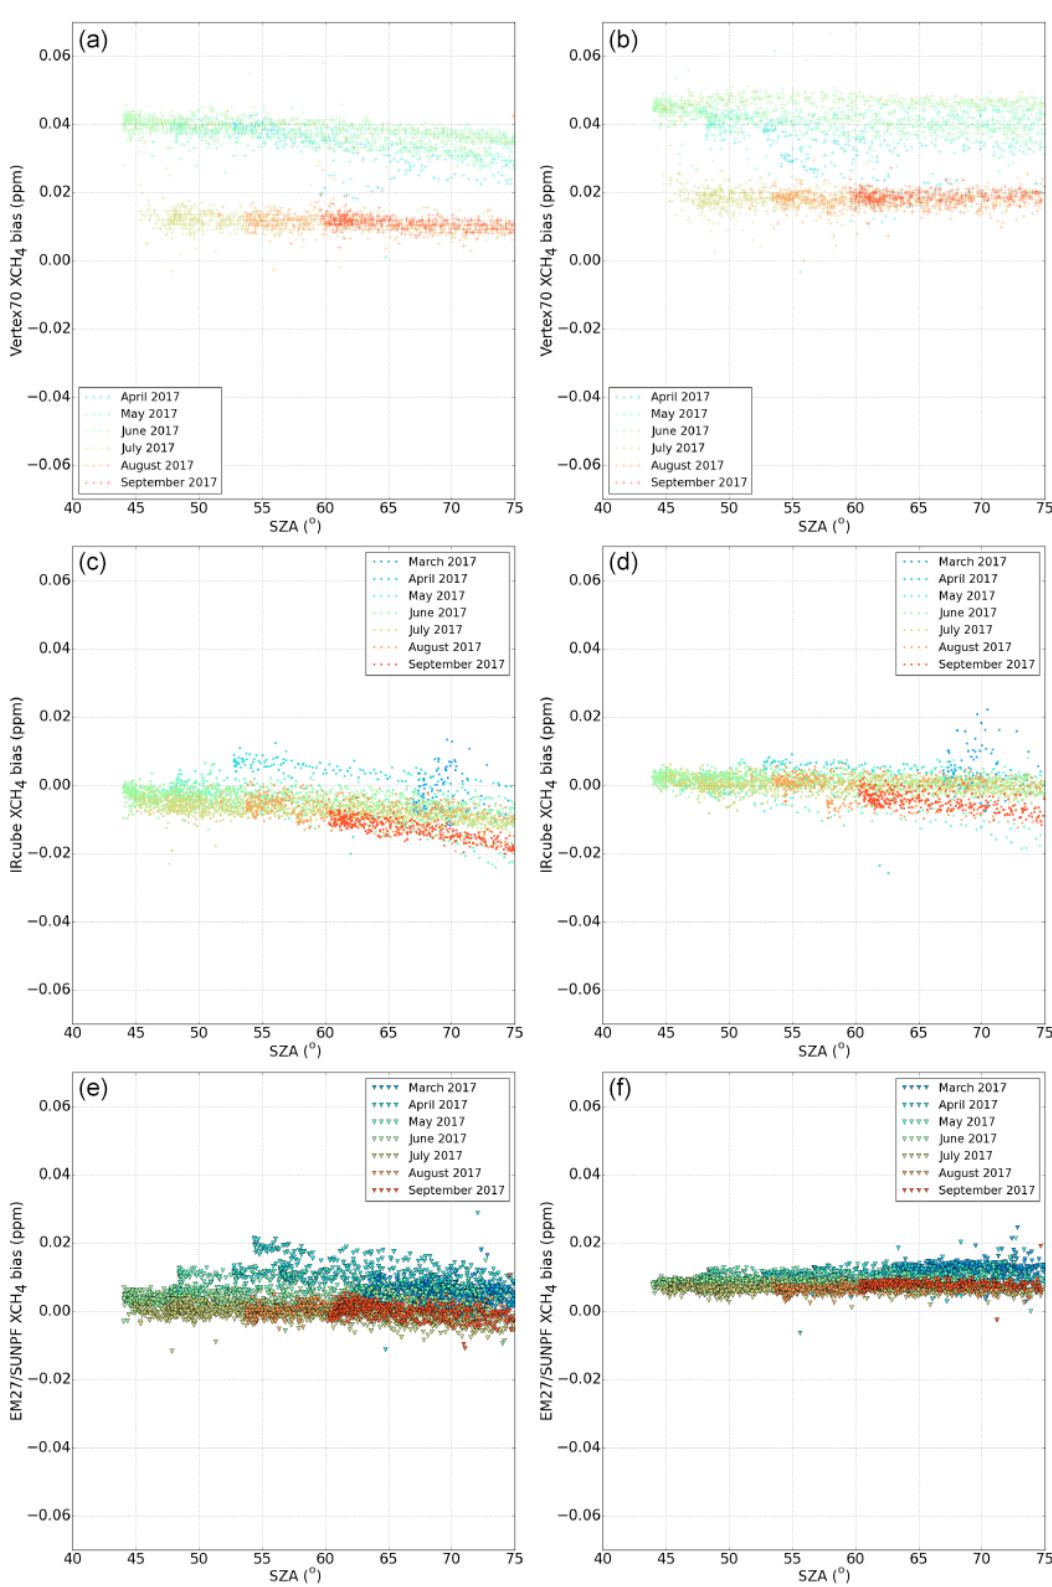
Figure E3. XCH 4 bias relative to TCCON (a, c, e) and relative to HR125LR (b, d, f) for each instrument plotted with respect to the solar zenith angle: Vertex70 (a, b) , IRcube (c, d) , EM27/SUN (e, f) . The colours represent the measurement performed during the different months of the